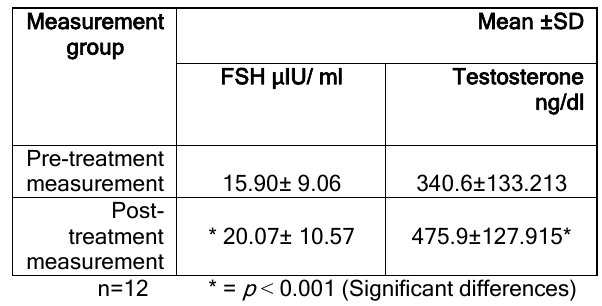
Table 1: The pre-post treatment values of FSH and Testosterone .